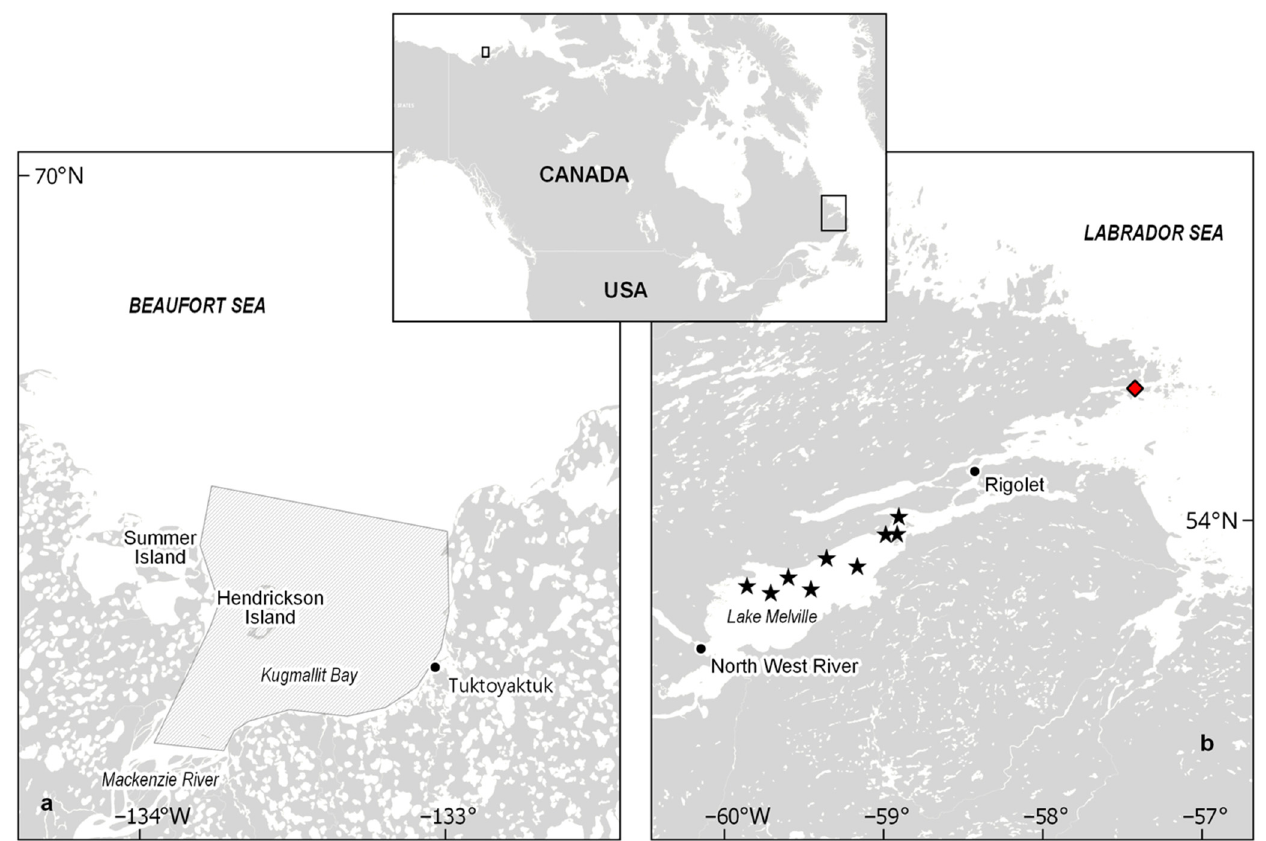
Figure 4. Sampling area (striped polygon) where belugas were harvested in the Beaufort Sea, Canada ( a ), and sampling sites of ringed seals from Lake Melville, Labrador, Canada ( b ). Ringed seals are represented by a black star, and the red diamond represents ringed seal #40, which was considered an outlier (see Section 2.1).